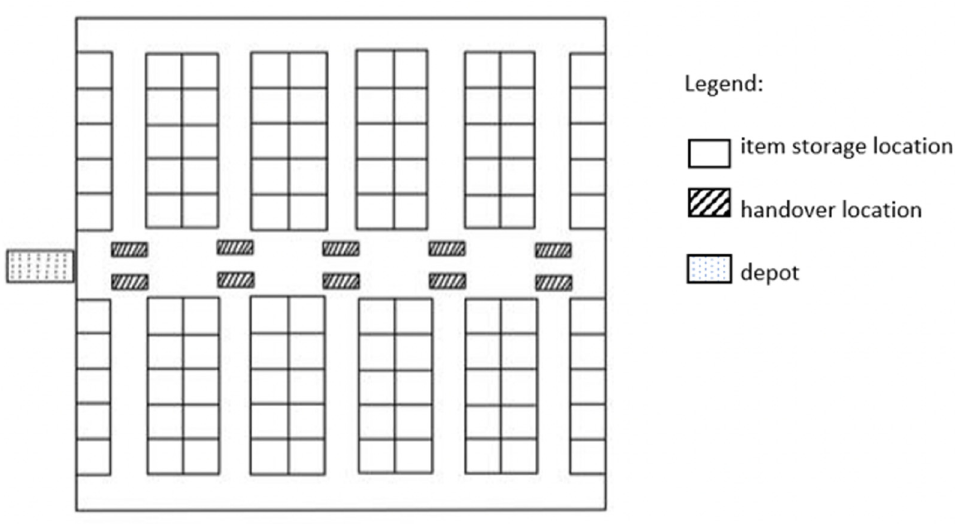
Figure 2. Warehouse with a two-blocks